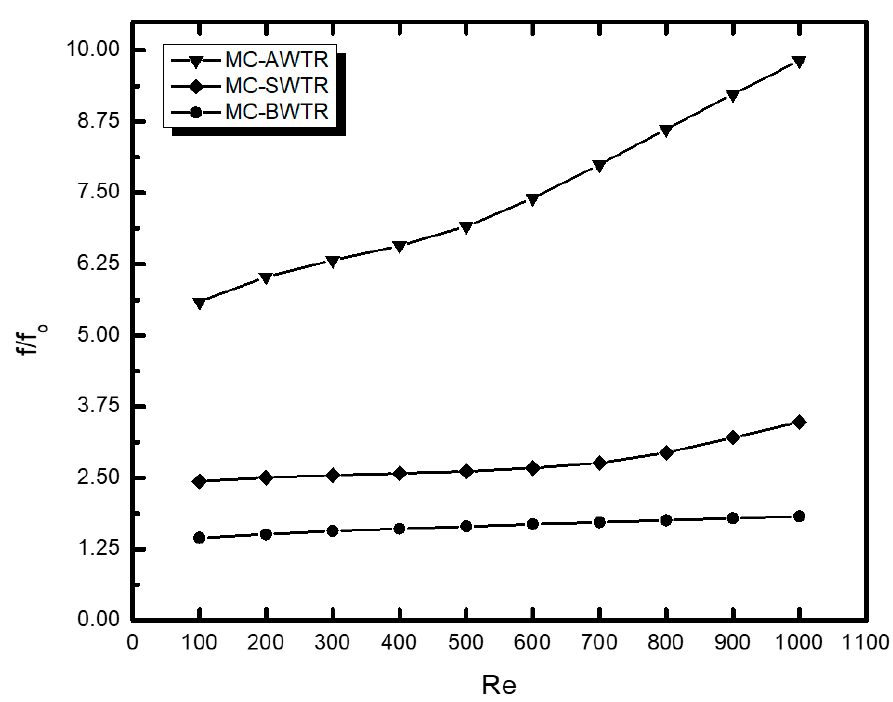
Figure 7. Comparison of friction factor ratio for different wall configurations MCHS.